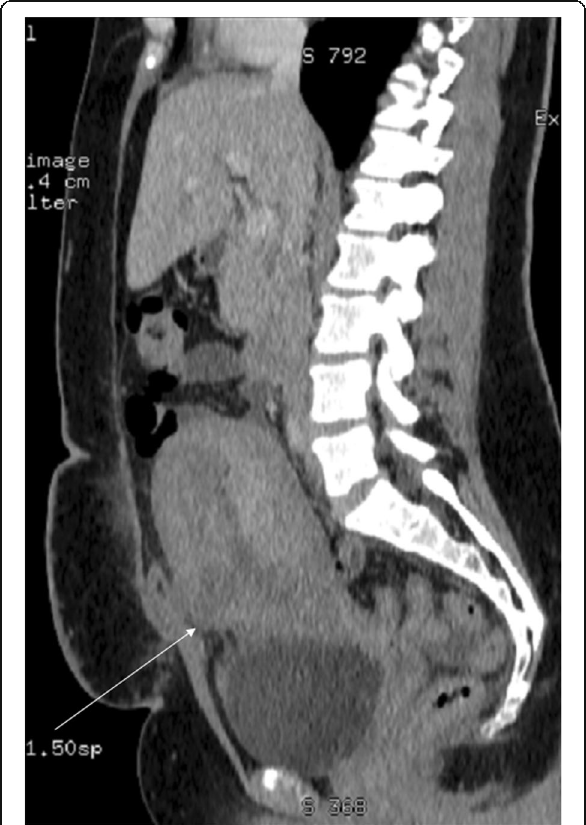
Fig. 2 A 34-year-old primigravida primipara 12 days after C-section complicated by dissection of the posterior wall of the uterus. CT in a venous phase shows the normal postoperative appearance of a recent cesarean delivery incision which is hypodense as compared to the intact myometrium (thin the evolution of the blood in the incision site and form- ing scar which may present T2-hypointesity due to fi- brous tissue (Fig. 3). If the uterine scar is incompletely healed, thinning and retraction of the uterine wall are observed with only residual myometrium adjacent to the scar. This forms a triangular or semicircular defect at the site of the scar which is T2-hyperintense and is